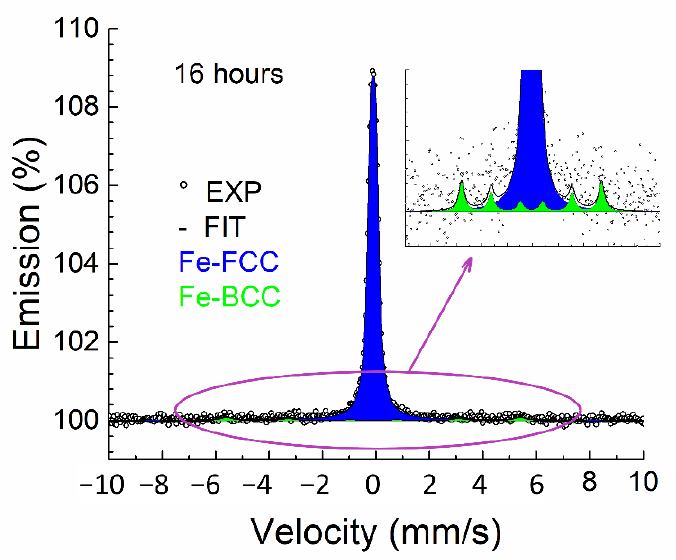
Figure 4. Conversion X-ray Mössbauer spectra of sample annealed at 550 °C for 16 h (measured for 430 h). Table 2. Conversion X-ray Mössbauer spectroscopy parameters of all samples (IS, isomer shift;